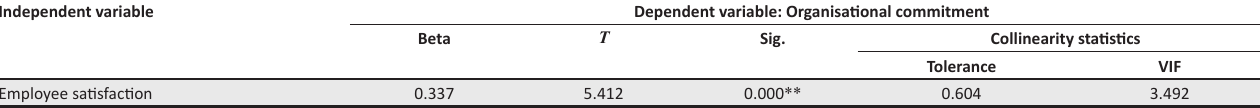
TABLE 6: Regression model 2 – employee satisfaction and organisational